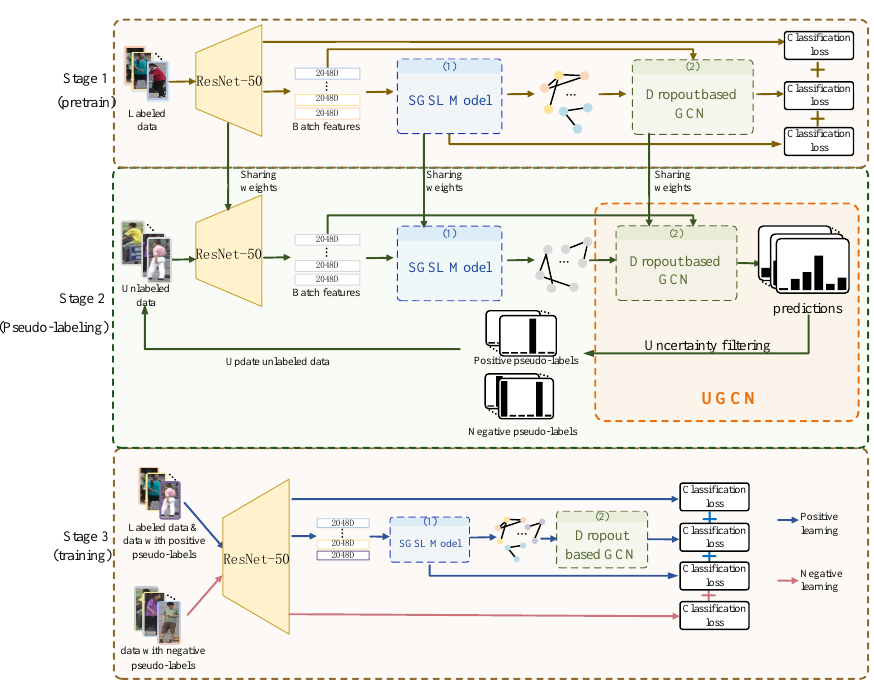
Figure 1. A positive and negative self-training framework based on graph-based deep uncertainty. The proposed framework is divided into three stages. In the first stage, a small number of labeled samples are fed into the network and trained using a supervised learning approach. In the second stage, the parameters are fixed and the network is tuned to the test mode. Unlabeled samples are inputted to predict and generate pseudo-labels by uncertainty filtering. Then original unlabeled data are updated by adding positive and negative pseudo-labels. In the third stage, the data with pseudo-labels are trained together with a small amount of labeled